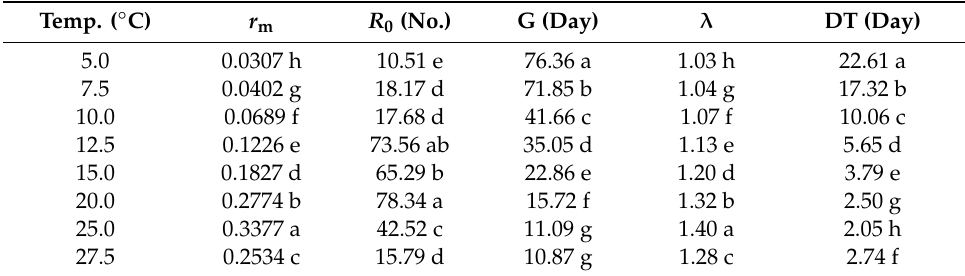
Table 9. Life table parameters of A. solani at di ff erent constant temperatures using age–stage, two-sex life table